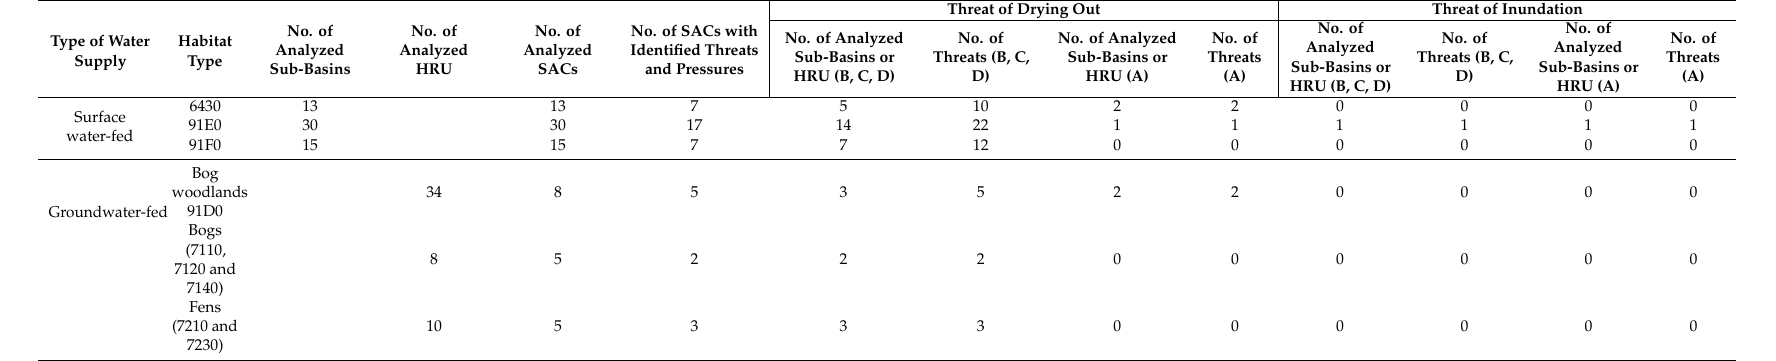
Table 3. Number of SWAT sub-basins and hydrologic response units (HRUs) included in the analysis for given types of habitats within the Vistula and Odra basins with an assessment of threats connected to drying out and inundation according to the conservation status of SACs (A or B, C, D). Number of threats identified within all the considered SACs (threats and pressures of drying out: K01.03—drying out; M01.02—droughts and less precipitations; J02.04.02—lack of